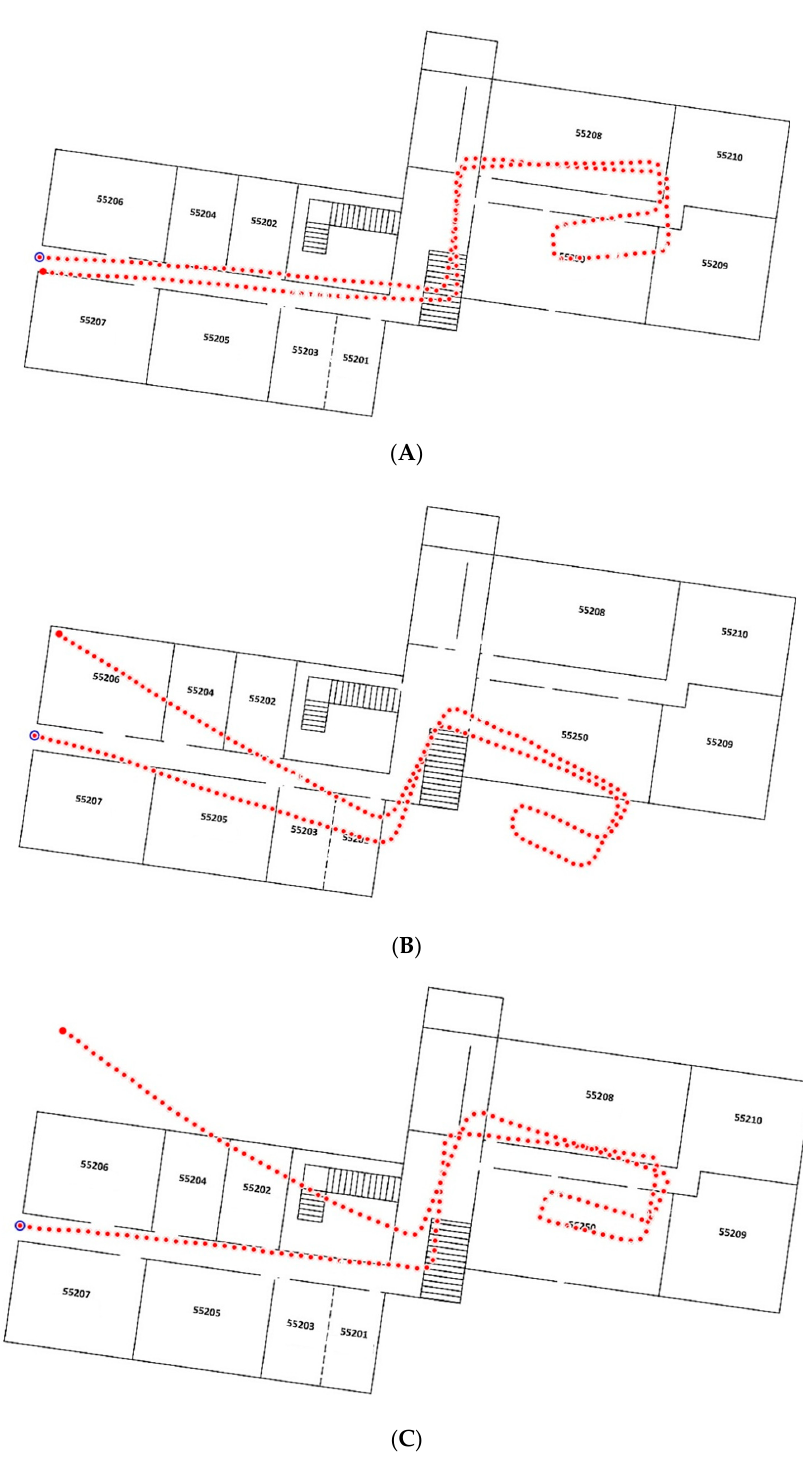
Figure 11. The experimental trajectories of PDR for different placements: ( A ) Smartphone close to the ear; ( B ) Smartphone in the pocket; ( C ) Smartphone on the belt. The numbers indicate the different classrooms.